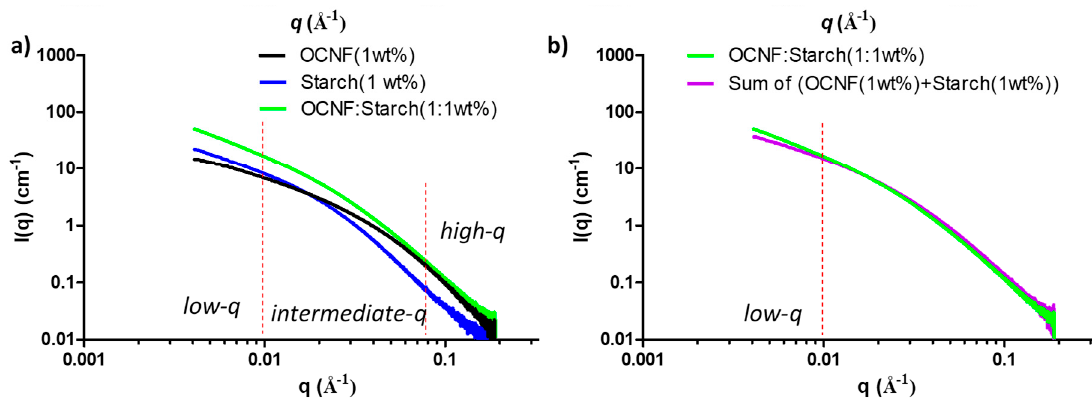
Figure 8. ( a ) Small-angle X-ray scattering (SAXS) patterns of the OCNF:starch blend hydrogels and ( b ) comparison between the SAXS curve of the blend hydrogel (green) with the calculated curve obtained by adding the signal of the two individual components (purple).